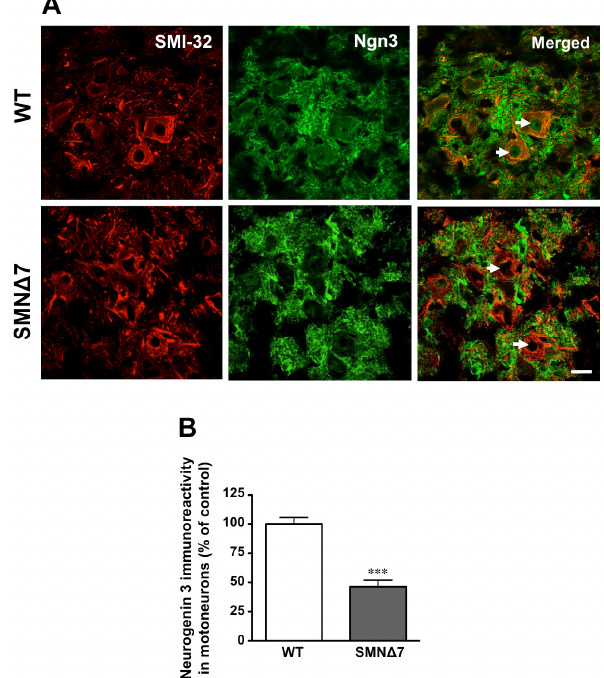
Figure 4. Decreased neurogenin 3 (Ngn3) expression in SMA spinal cord motoneurons. ( A ) Representative images of SMI-32 and Ngn3 immunohistochemistry in the ventral horn of lumbar spinal cord of P11 wild-type (WT) and SMN Δ 7 mice showing that motoneurons are co-labeled with these antibodies (merge), and display decreased Ngn3 expression in SMN Δ 7 mice. Arrows point to the nuclei of motoneurons to indicate the lack of Ngn3 immunoreactivity in SMN Δ 7 mouse. Scale bar = 20 μ m applies to all photographs in ( A ). ( B ) Columns represent the percentage of Ngn3 immunoreactivity in SMI-32 positive cells (motoneurons) in the lumbar spinal cord of P11 SMN Δ 7 as compared to control (WT) mice and represent the mean ± SEM (error bars) of at least four mice for each group. *** p < 0.001 as compared to age-matched